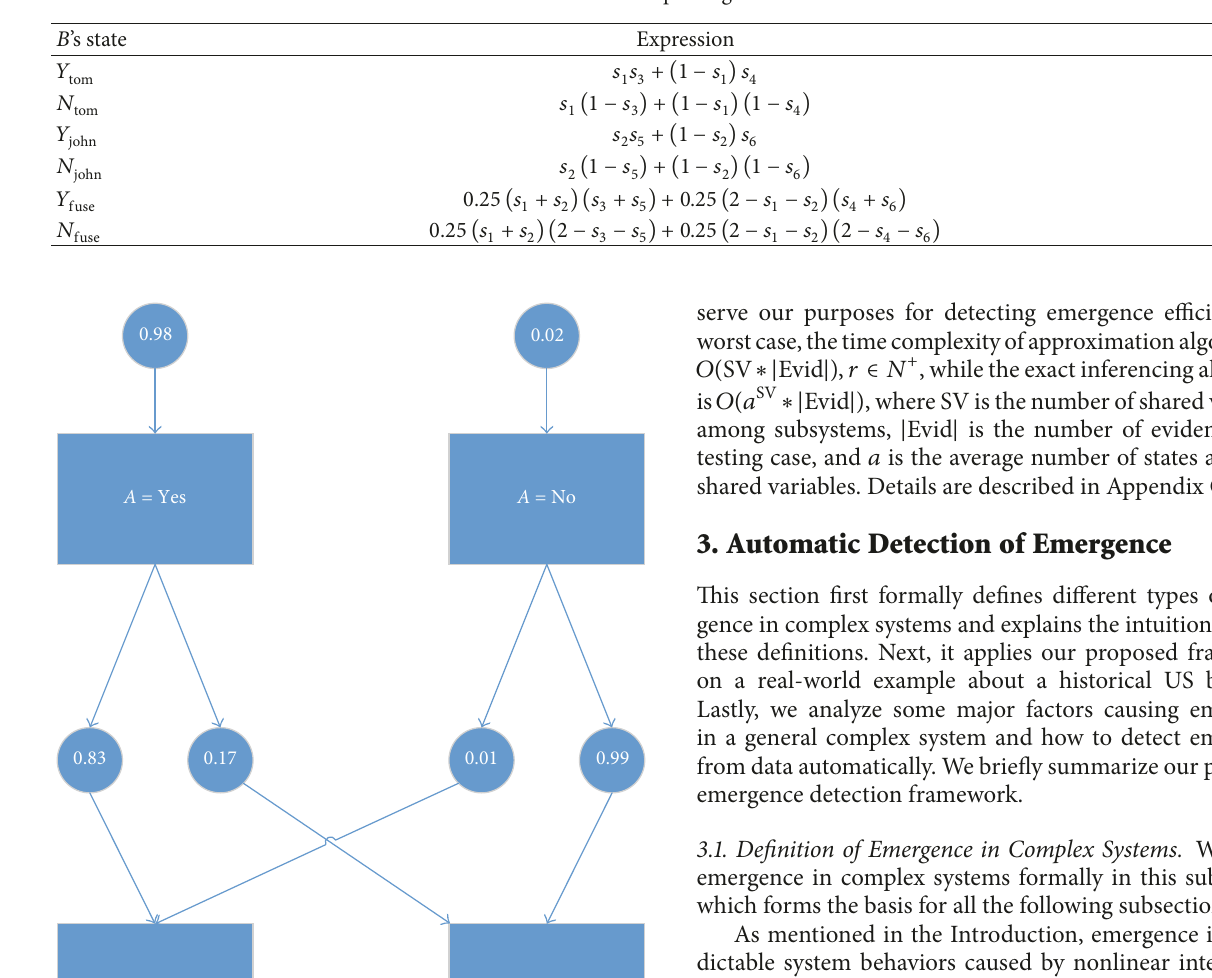
Table 2: Belief updating of 𝐵 ’s state.